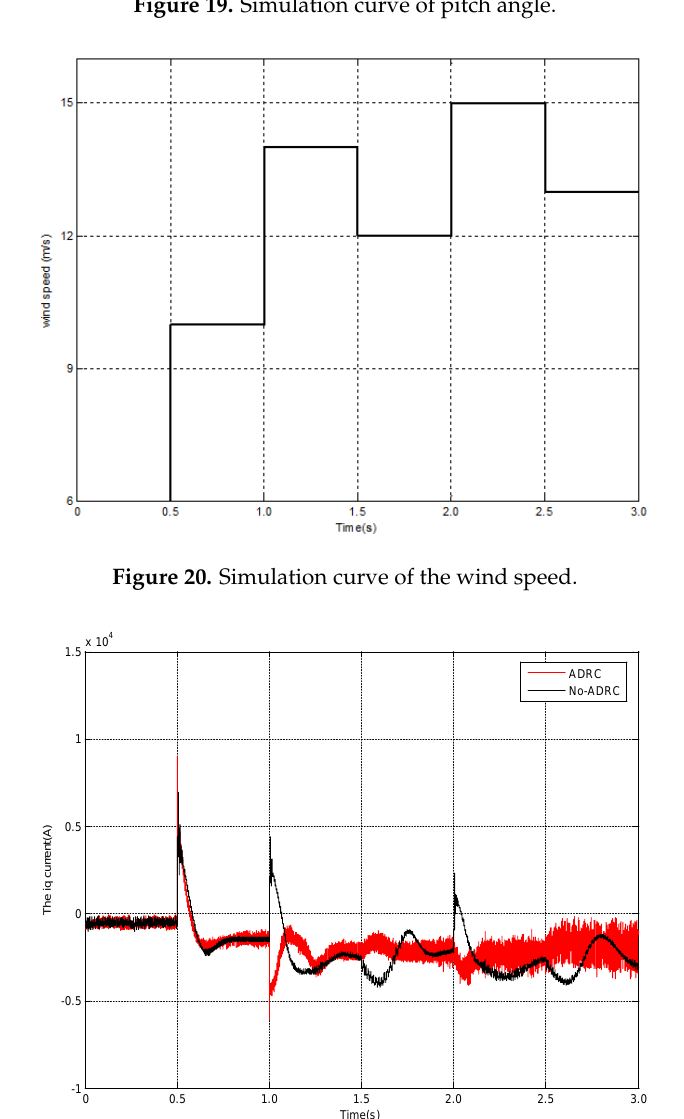
Figure 19. Simulation curve of pitch angle.